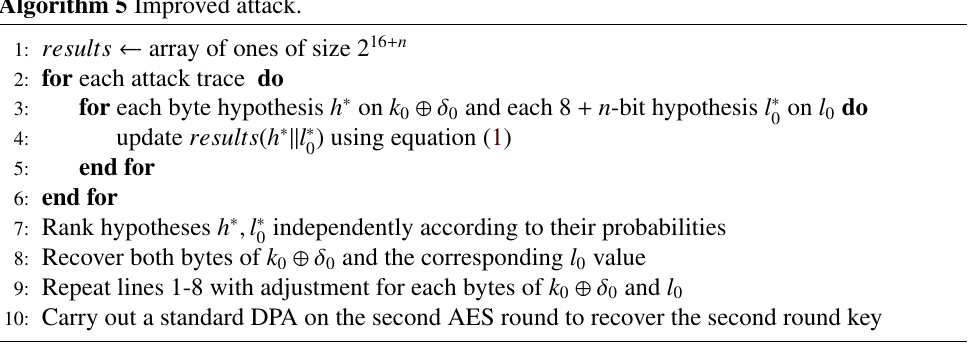
Algorithm 5 Improved attack.